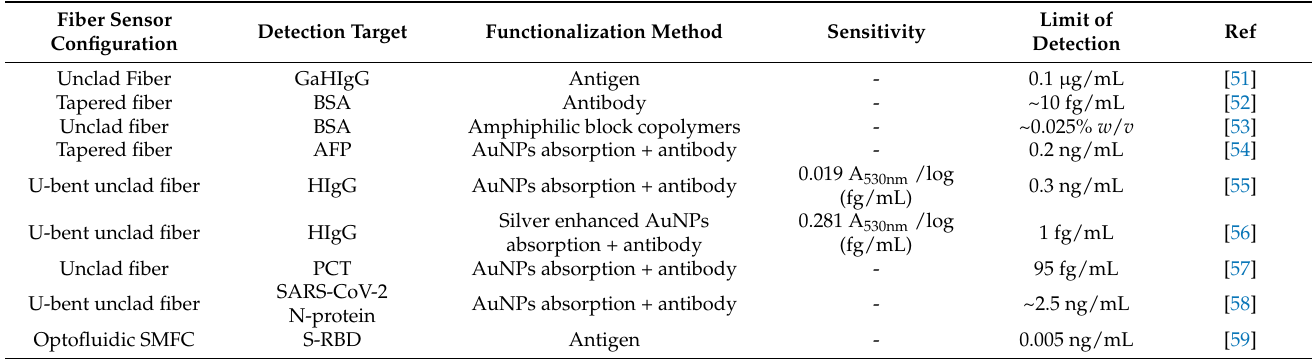
Table 1. Intensity-based fiber biosensors for protein